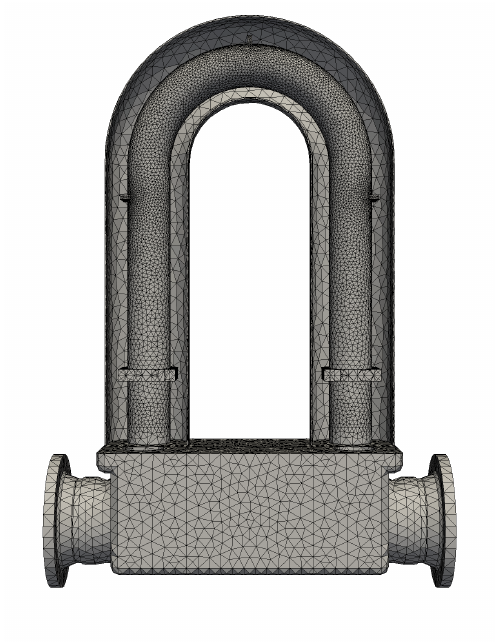
Figure 6. Clip representation of the volume mesh.